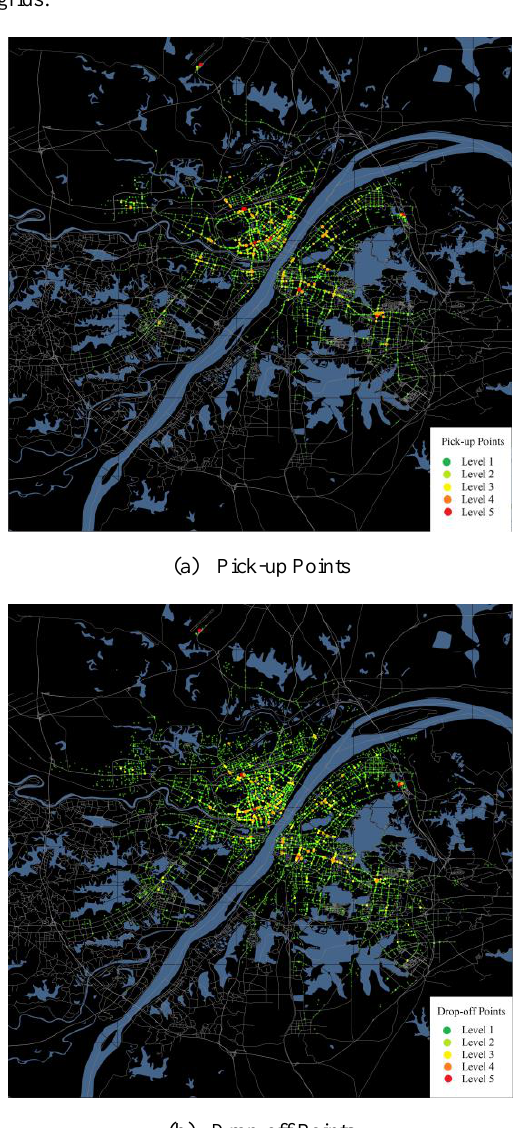
Figure 3. Spatial distributions of docking